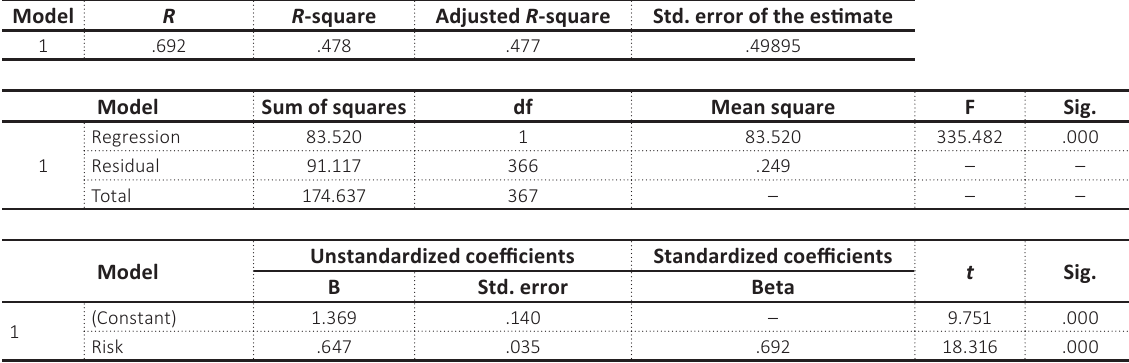
Table 7. Model summary, ANOVA, coefficients of 4th sub-hypothesis